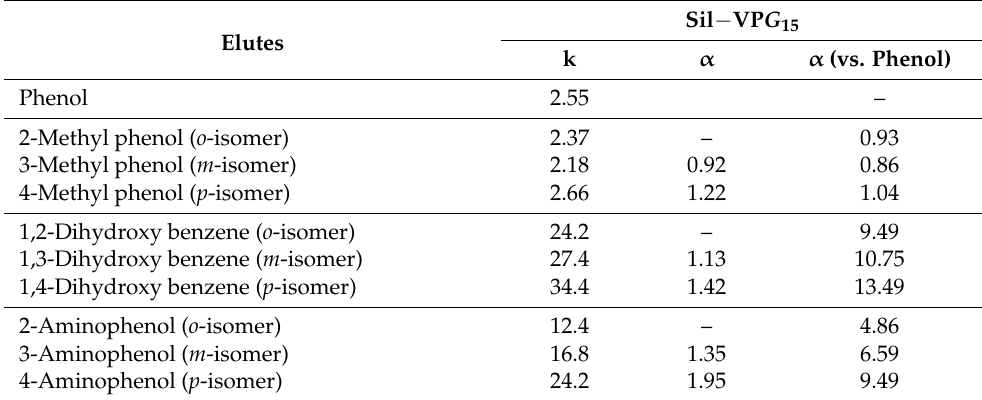
Table 3. Retention factors (k) and separation factors ( α ) of disubstituted benzenes using Sil − VP G 15 and